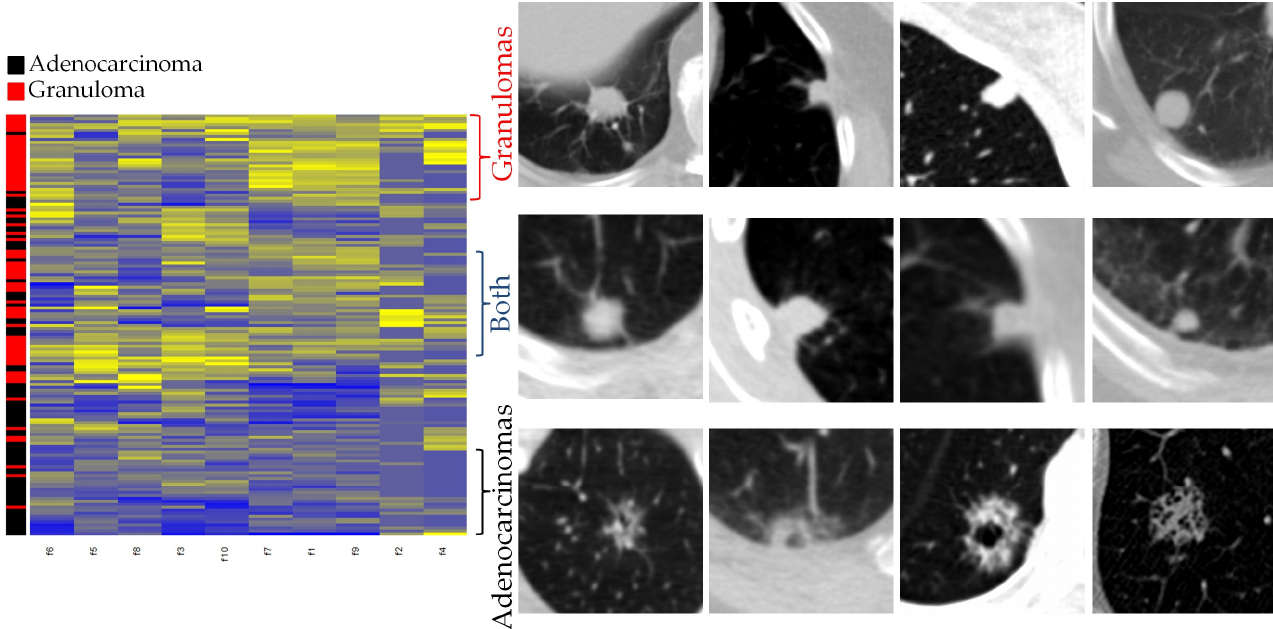
Figure 6. Hierarchical clustering of nodules described with top NIS features ( left panel ). ( Right panel ): Four example nodules per each emerging sub group/clusters corresponding to granulomas, suspicious nodules and